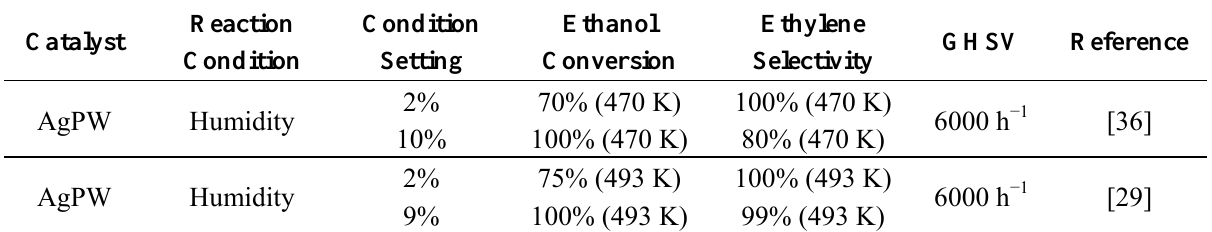
Table 4. Effect of humidity on catalytic ability of AgPW